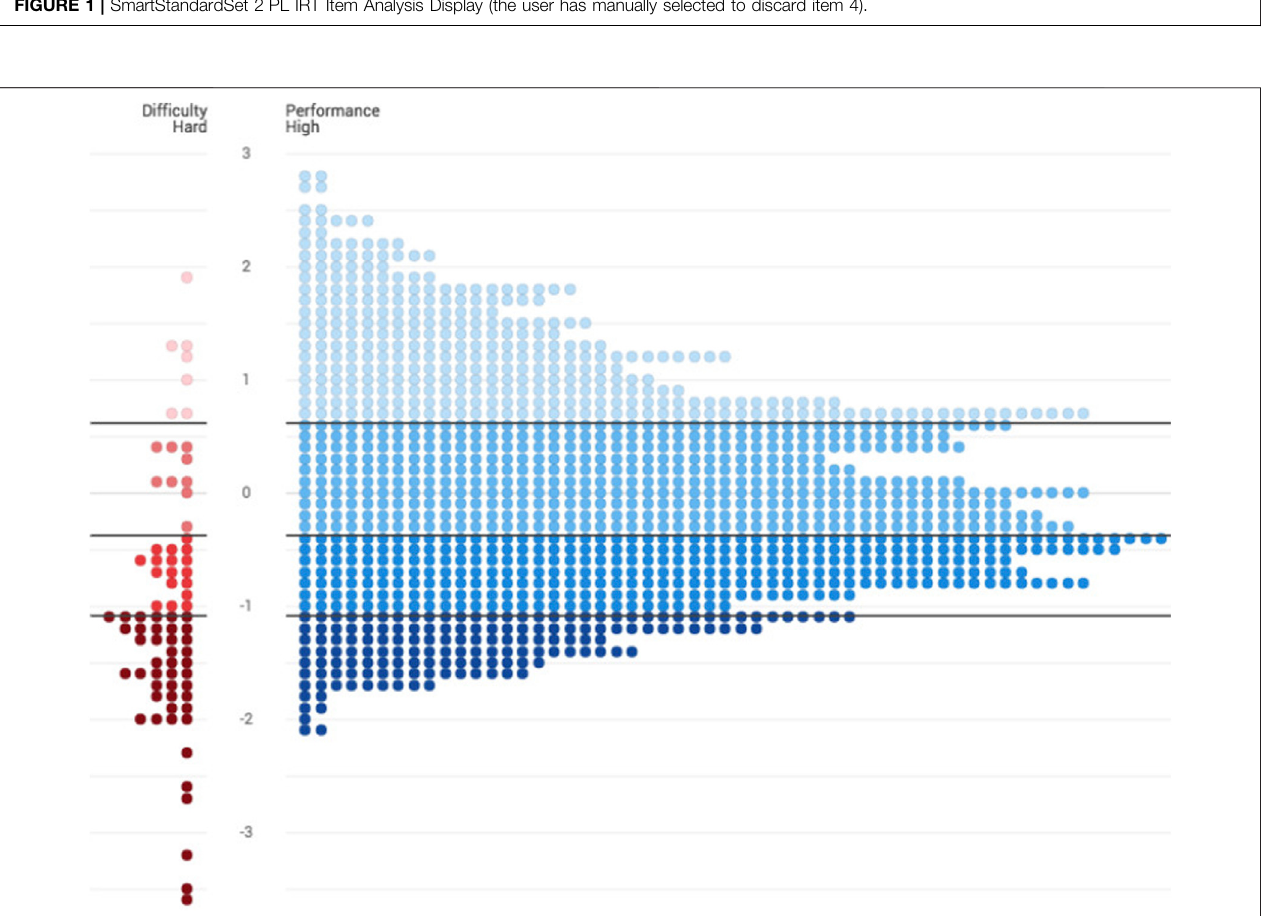
FIGURE 2 | SmartStandardSet IRT and person score location